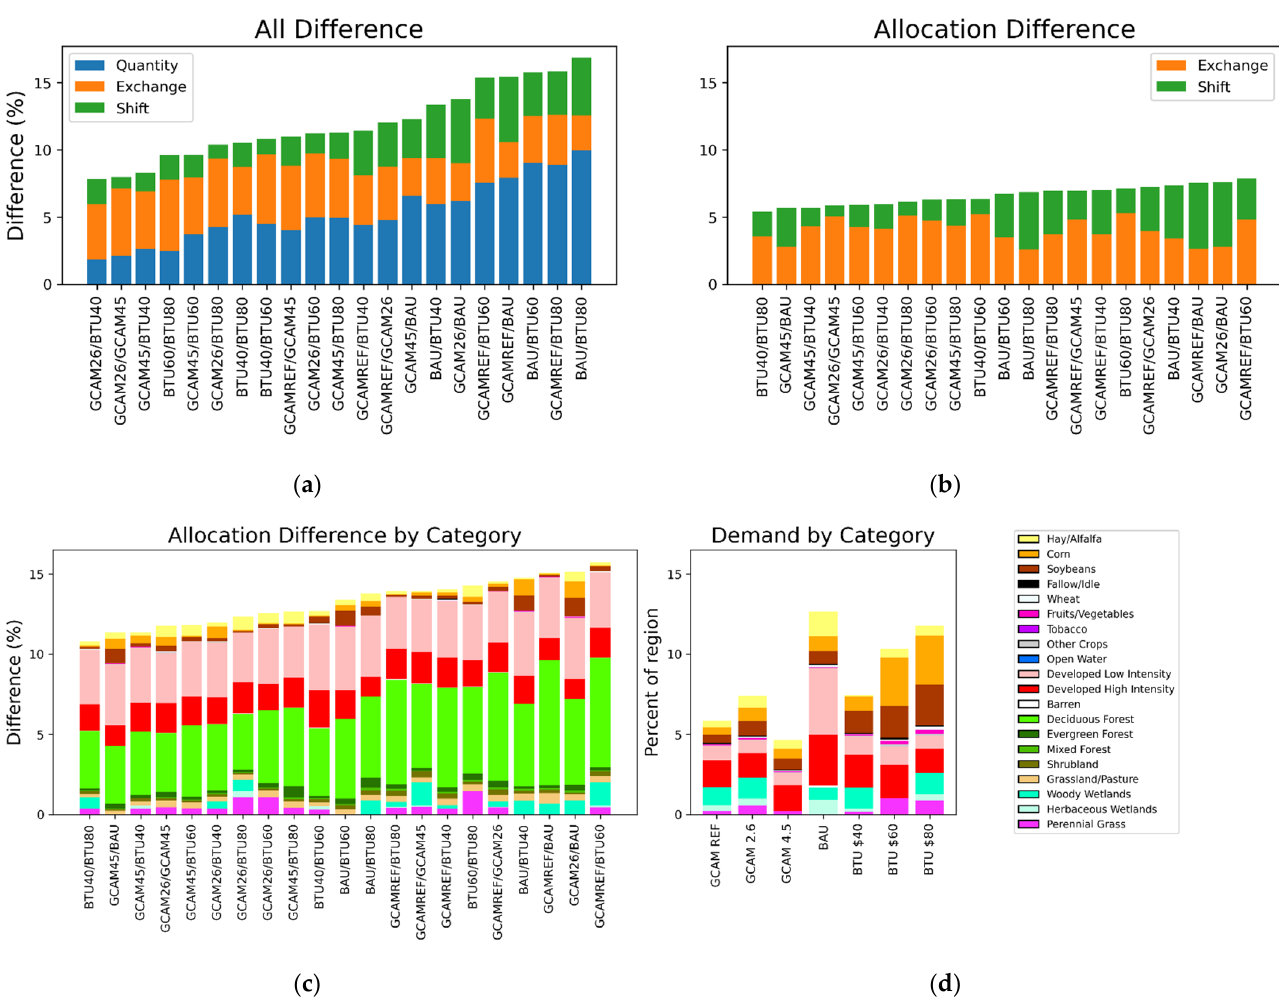
Figure 7. Difference between modeled scenario combinations for the year 2100 for ( a ) all components of difference (quantity, exchange, and shift); ( b ) spatial allocation difference (exchange and shift); ( c ) spatial allocation difference by land cover category; ( d ) cumulative (2020–2100) absolute (positive and negative) prescribed change by scenario and land cover category.